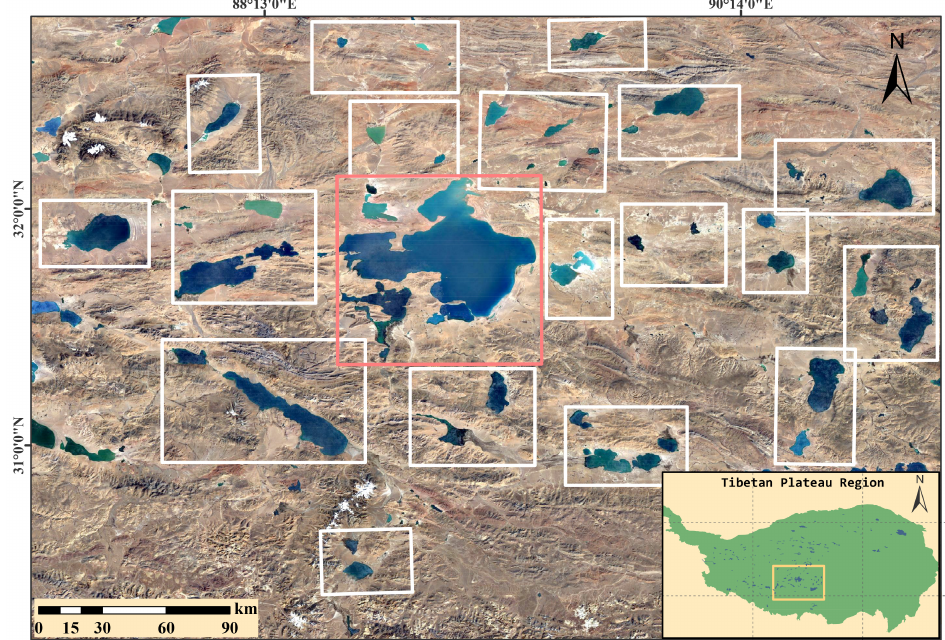
Figure 2. Study area in central Tibet by using Landsat-8 RGB composition with the training and test areas are outlined by the white and red boxes,